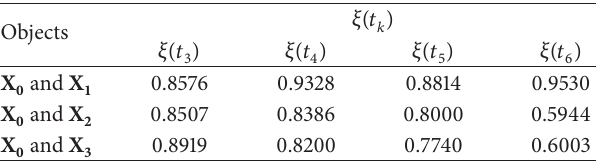
Table 3: The relational coefficients between X 0 and other three time